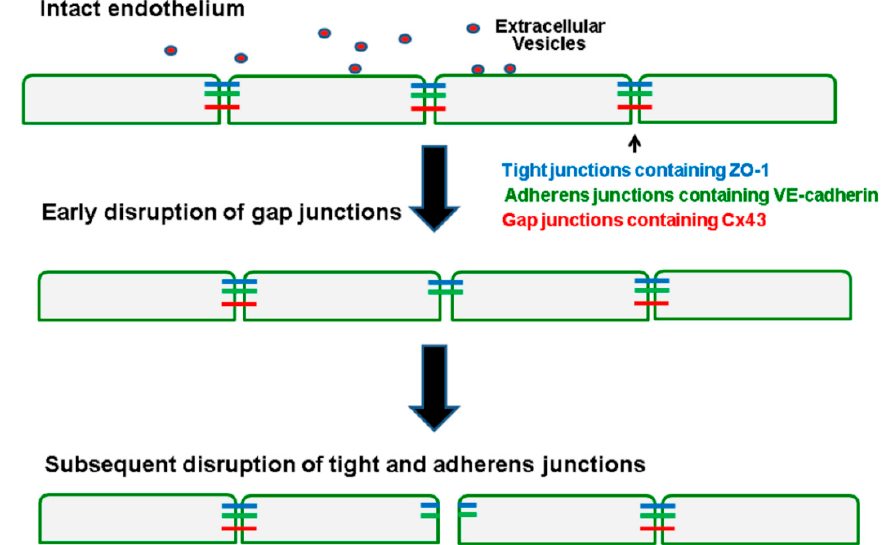
Figure 7. Model illustrating the progressive sequence of changes in the endothelium caused by EVs isolated from a subject with SCD during an ACS episode. After the endothelial monolayer is treated with EVs, there is early disruption of gap junctions containing Cx43 (red), followed by subsequent disruption of tight junctions containing ZO-1 (blue) and adherens junctions containing VE-cadherin (green).